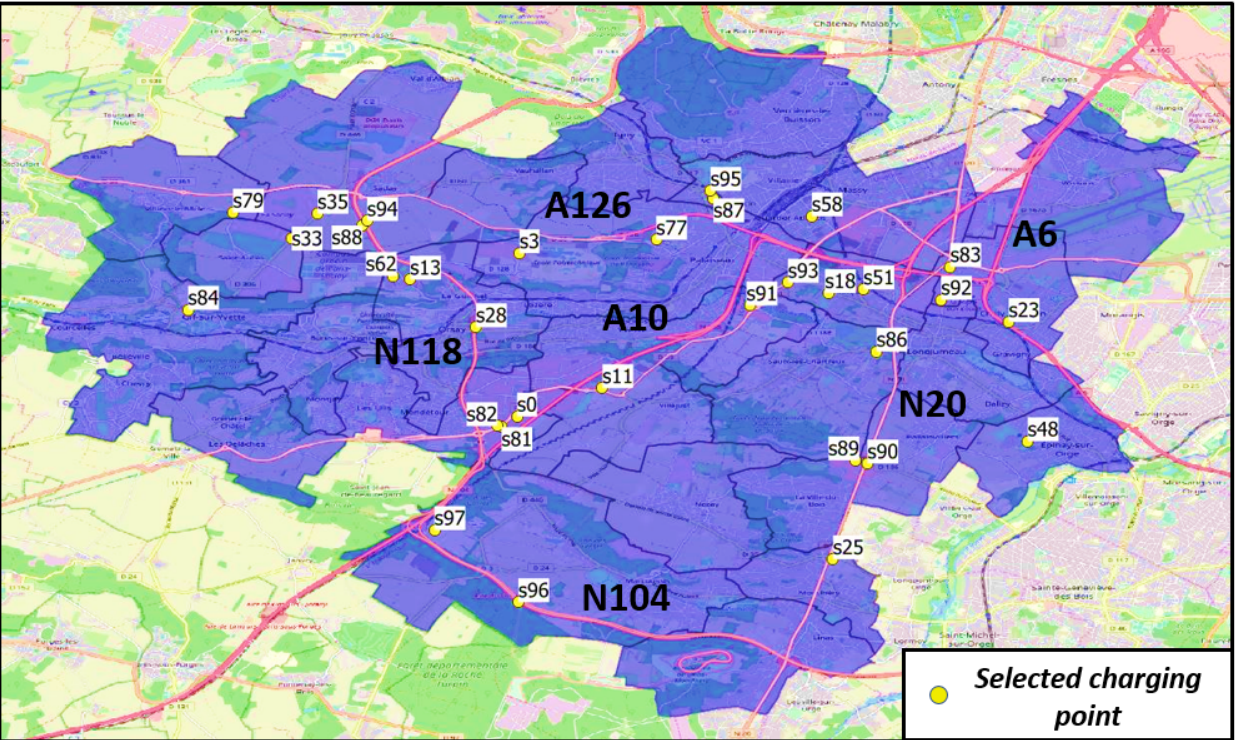
Figure 4. EV charging network: Selected charging points.